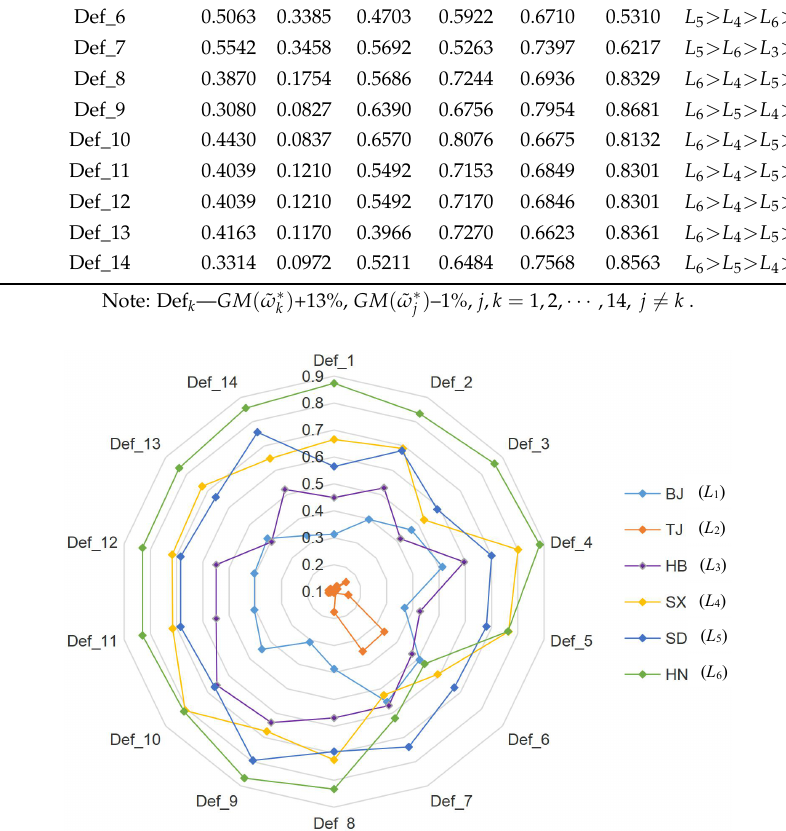
Figure 5. Sensitivity analysis